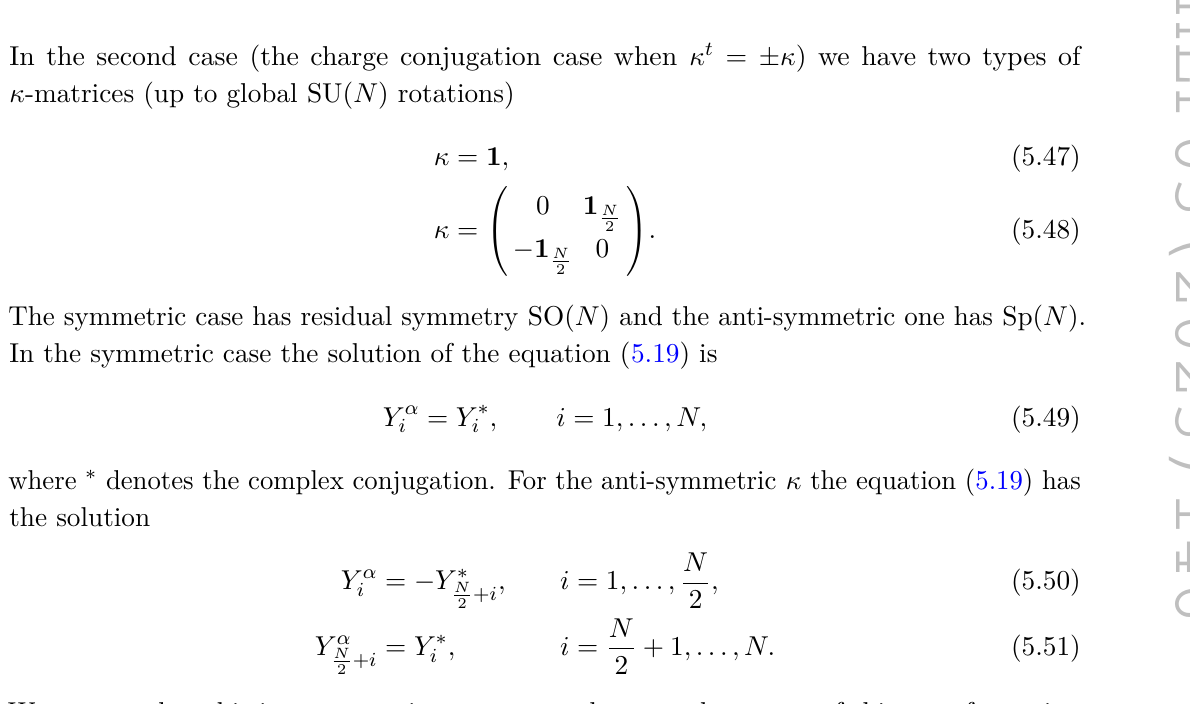
Table 4 . Crosscaps of C P 3 sigma